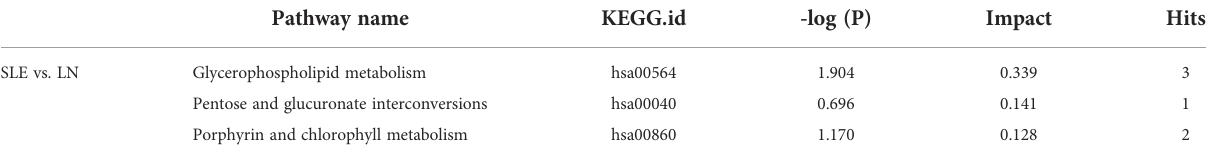
TABLE 2 Top three signi fi cantly altered metabolic pathways between